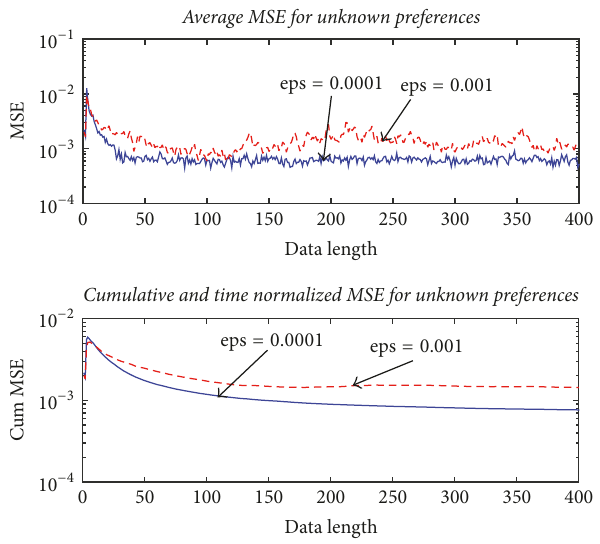
Figure 4: Estimation of the underlying preferences vector when there is no feedback. The results are averaged over 100 independent trials. Here, we have no feedback and parameters of both the state equation and the observation equation are unknown. The results are shown for two different noise variances for the EKF formulation.